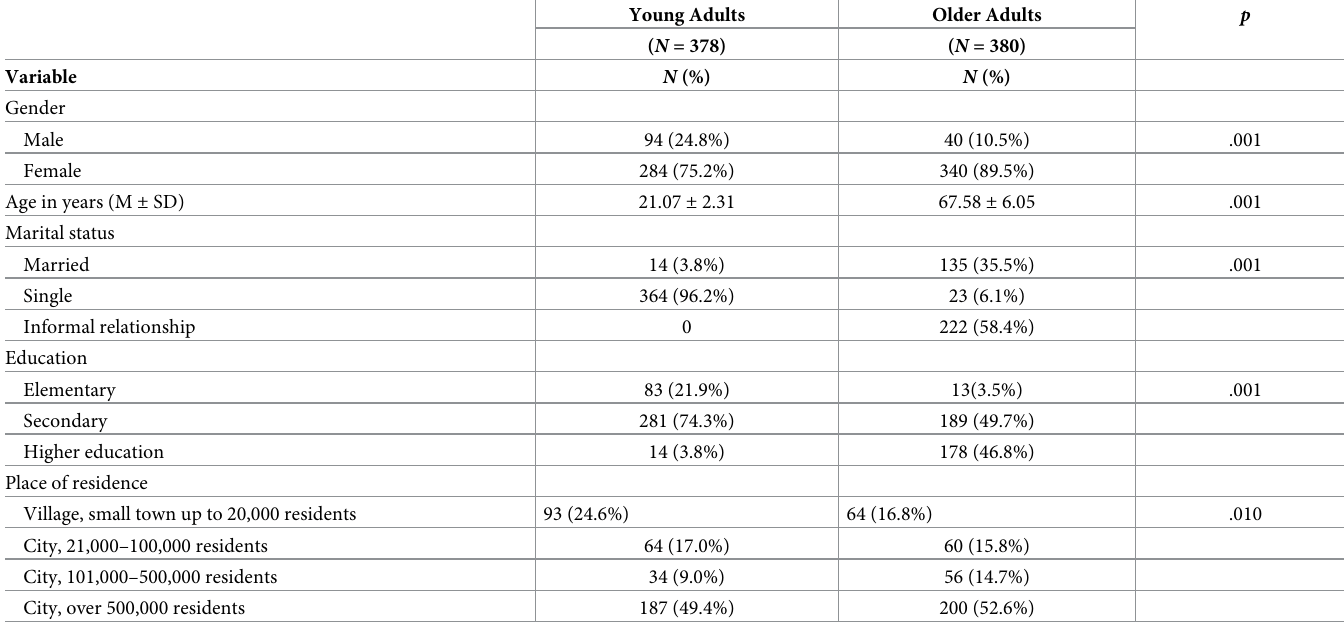
Table 1. Sociodemographic variables in the studied sample (N =